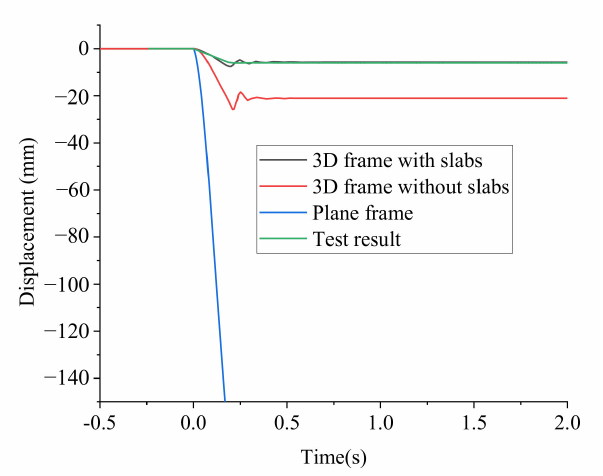
Figure 4. Displacement–time curves of different detailed solid-element models simulating the